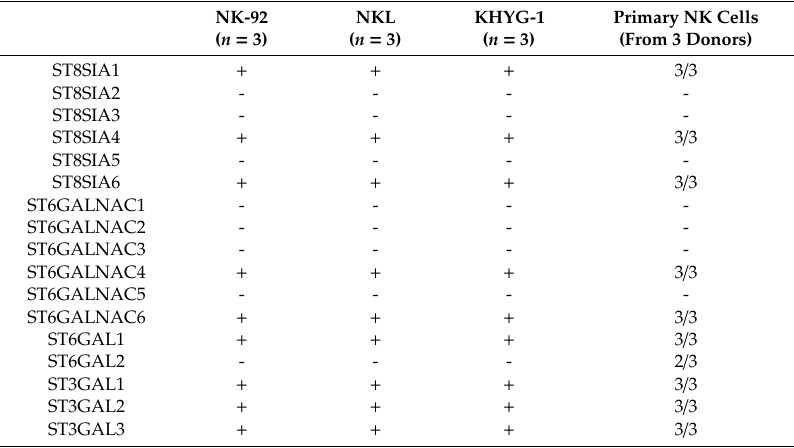
Table 2. Expression of sialyltransferases in human NK